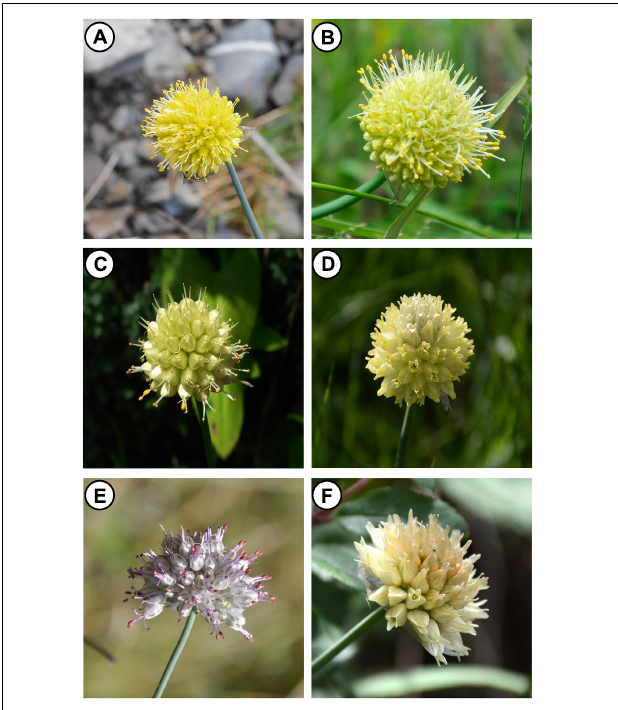
FIGURE 1 | The flower morphological characters of Section Daghestanica species. (A) A. chrysanthum , (B) A. rude , (C) A. xichuanense , (D) A. chrysocephalum , (E) A. maowenense , and (F) A. herderianum